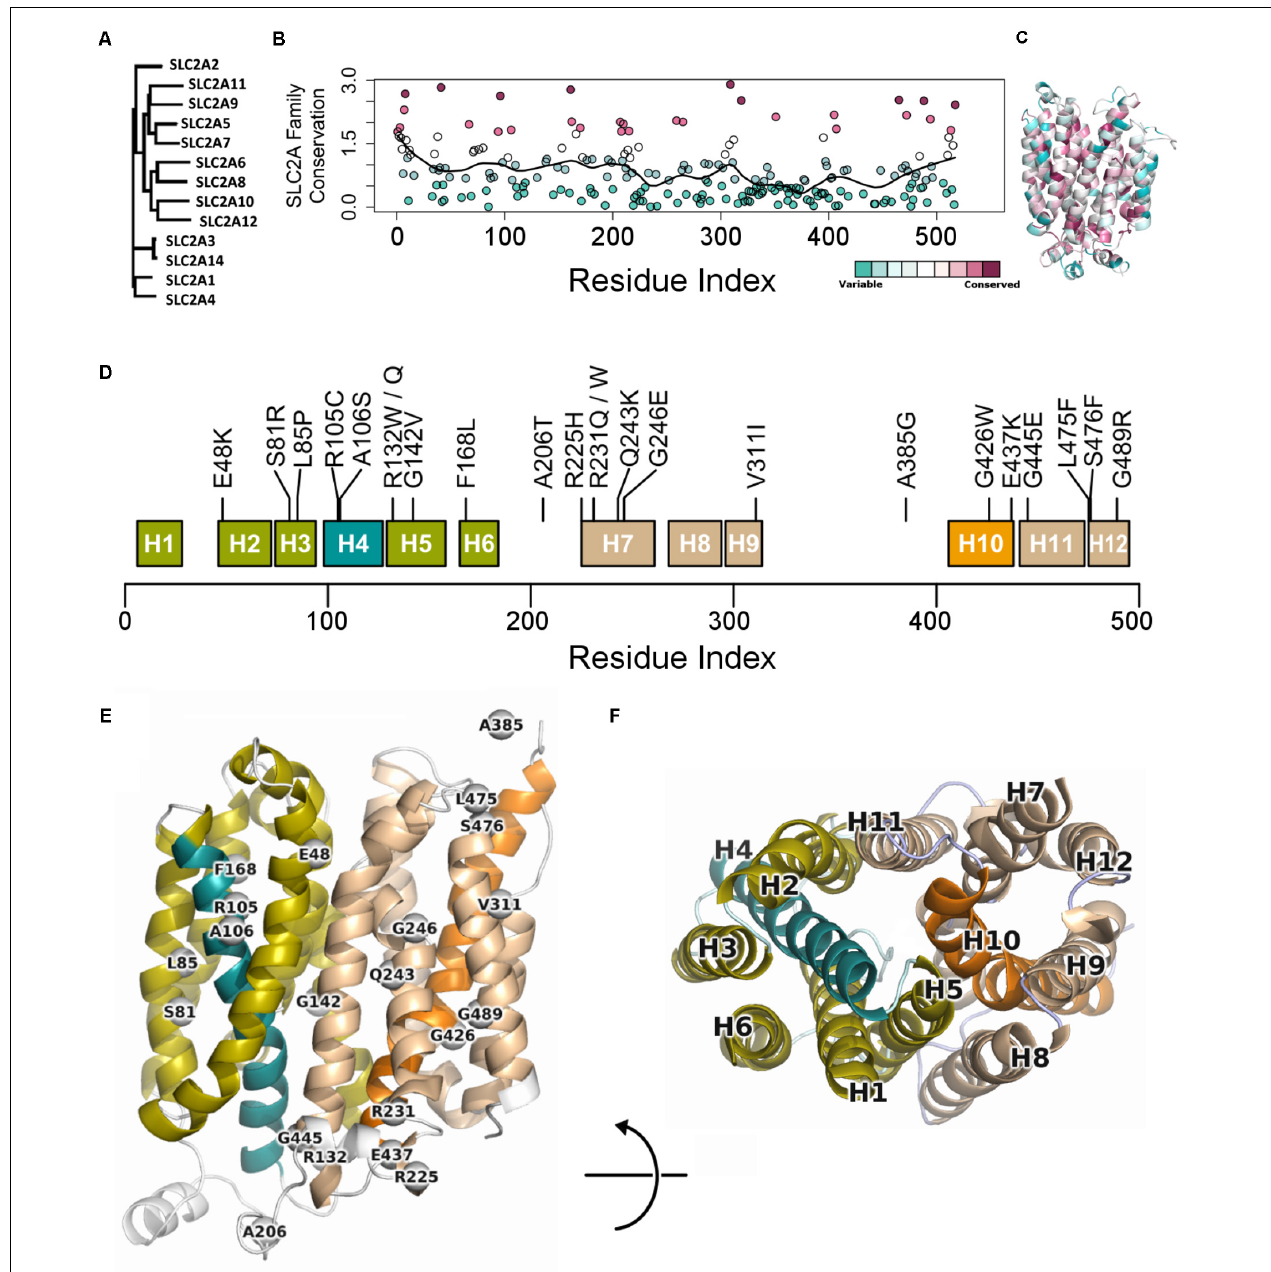
FIGURE 1 | Conservation across human paralogs of GLUT10. (A) Phylogenetic tree indicating the relative amino acid sequence relatedness of paralogs to each other. (B) The per-residue conservation scores using the SLC2A family MSA and as computed by ConSurf, are shown along with a smoothed average (black line). Regions of high conservation are distributed across the sequence. (C) Our model of IF SLC2A10 is shown colored by ConSurf conservation. While more highly conserved regions are distributed across the sequence, they tend to coincide with the inner portions of the channel that will interact with ligands. (D) Locations of the 23 GLUT10 variants studied. Some amino acids have multiple observed alterations at the same site, such as R132W and R132Q. GLUT10 is organized into two sub-domains or helical bundles, colored olive and tan. Each bundle is organized around H4 or H10, highlighted in teal and orange, respectively. (E) The modeled variants are distributed throughout the GLUT10 structure as depicted on our IF model, but tend to occur on the intracellular side and within the core of each helical bundle. (F) TM helices are numbered according to their sequential order and viewed from the intracellular side.